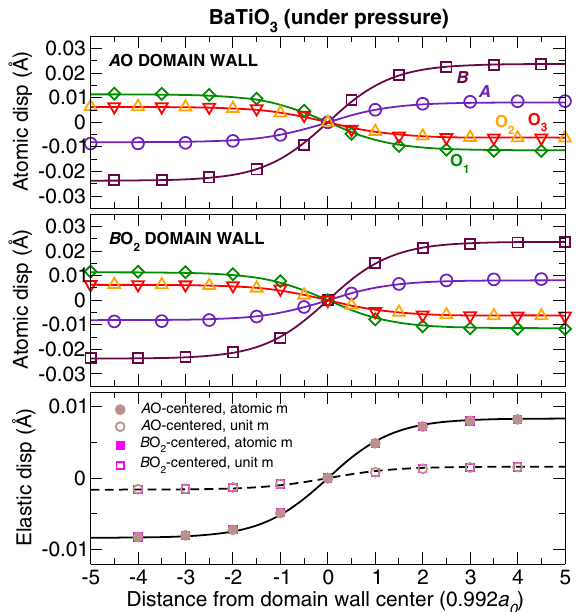
FIG. 5. Atomic displacements parallel to an A O domain wall (top panel) and to a B O 2 wall (middle panel), and elastic displacement (bottom panel), as a function of the distance from the domain wall. In all cases the system studied is compressed BaTiO 3 , built using supercells with a lattice parameter of 0 . 992 a